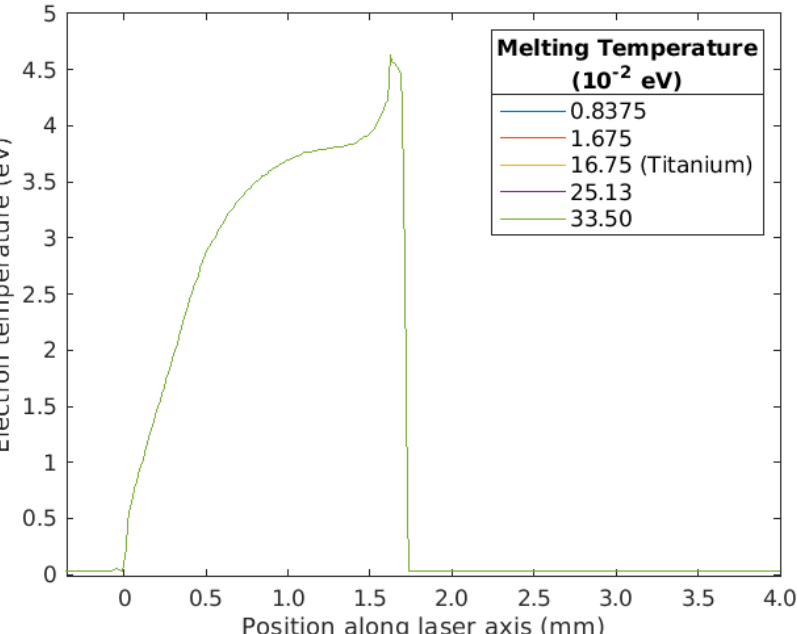
Figure 6. Comparison of the spatial distribution of the electron temperature of an ablated titanium plasma plume with varied melting temperature 25 ns after the laser pulse. The default melting temperature of titanium is 1.675 meV. The laser fluence was 100.5 J cm − 2 and the laser focus was 100 µ m. The curves overlap with each other completely. As such, only the last curve (corresponding to 33.50 × 10 − 2 eV) is visible in the figure.